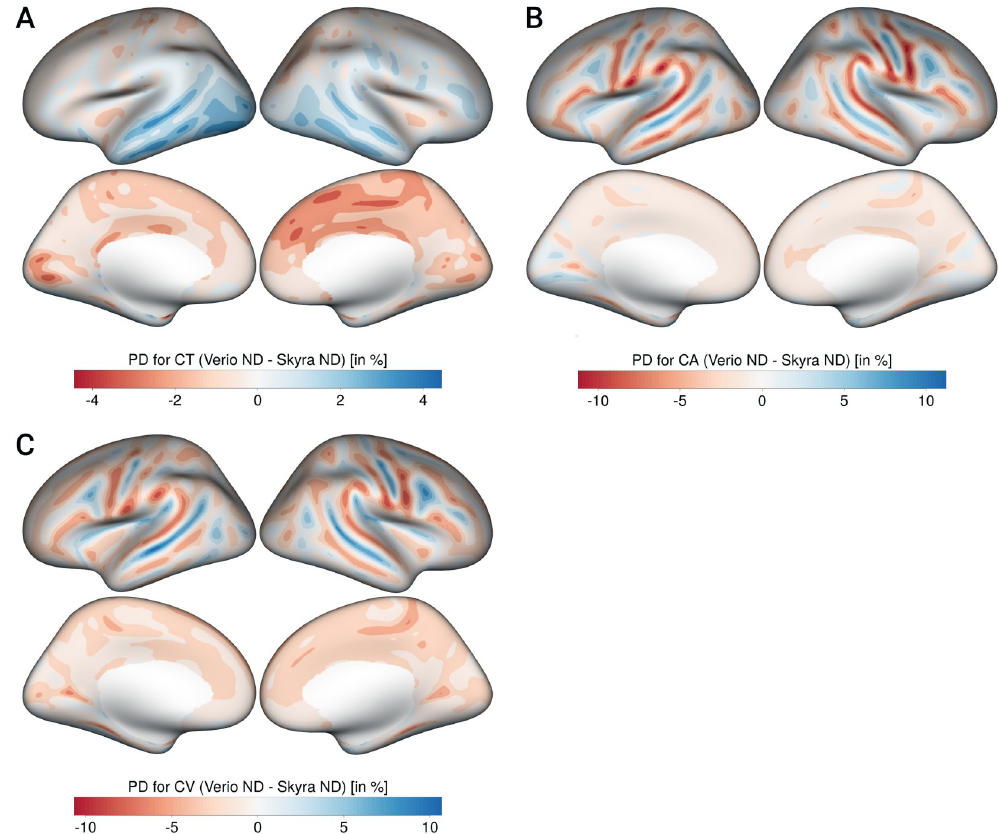
Fig 5. Bias patterns for CT (A), CA (B) and CV (C) shown on inflated white surface. Left column in each panel shows lateral and medial view of left hemisphere, right column shows lateral and medial view of right hemisphere), negative values: Skyra > Verio, positive values: Verio > Skyra. CT: Cortical thickness, CA: Cortical area, CV: Cortical